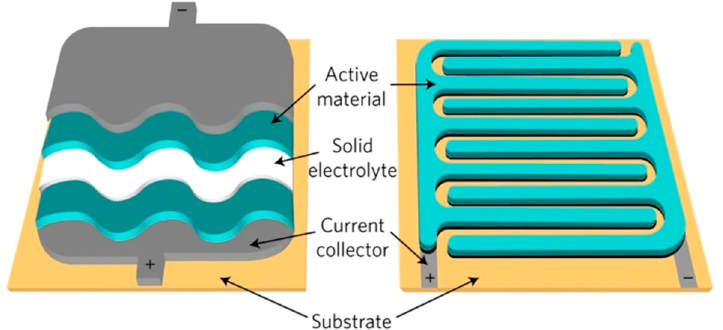
Figure 10. Schematic illustration of the configurations of microsupercapacitors. Left : stacked configuration. Right : in-plane interdigitated configuration. Reprinted by permission from Macmillan Publishers Ltd.: nature nanotechnology (ref. [109]), copyright (2017).